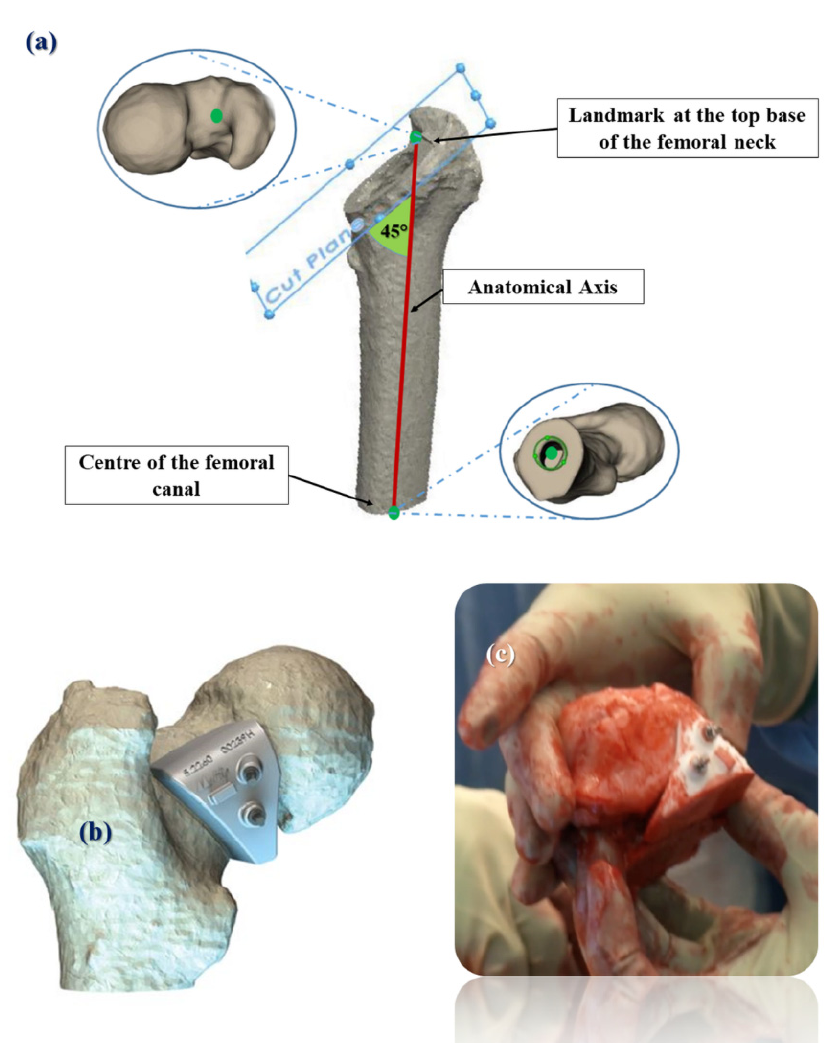
Figure 2. ( a ) Schematic illustration of the surgical plan; ( b ) Illustration of the 3D-printed Patient- Specific (PS) femoral osteotomy guide; ( c ) Two pins secure its position and the surgeon cuts the femoral neck using the saw blade. The femoral head–neck junction is then removed with the guide attached.